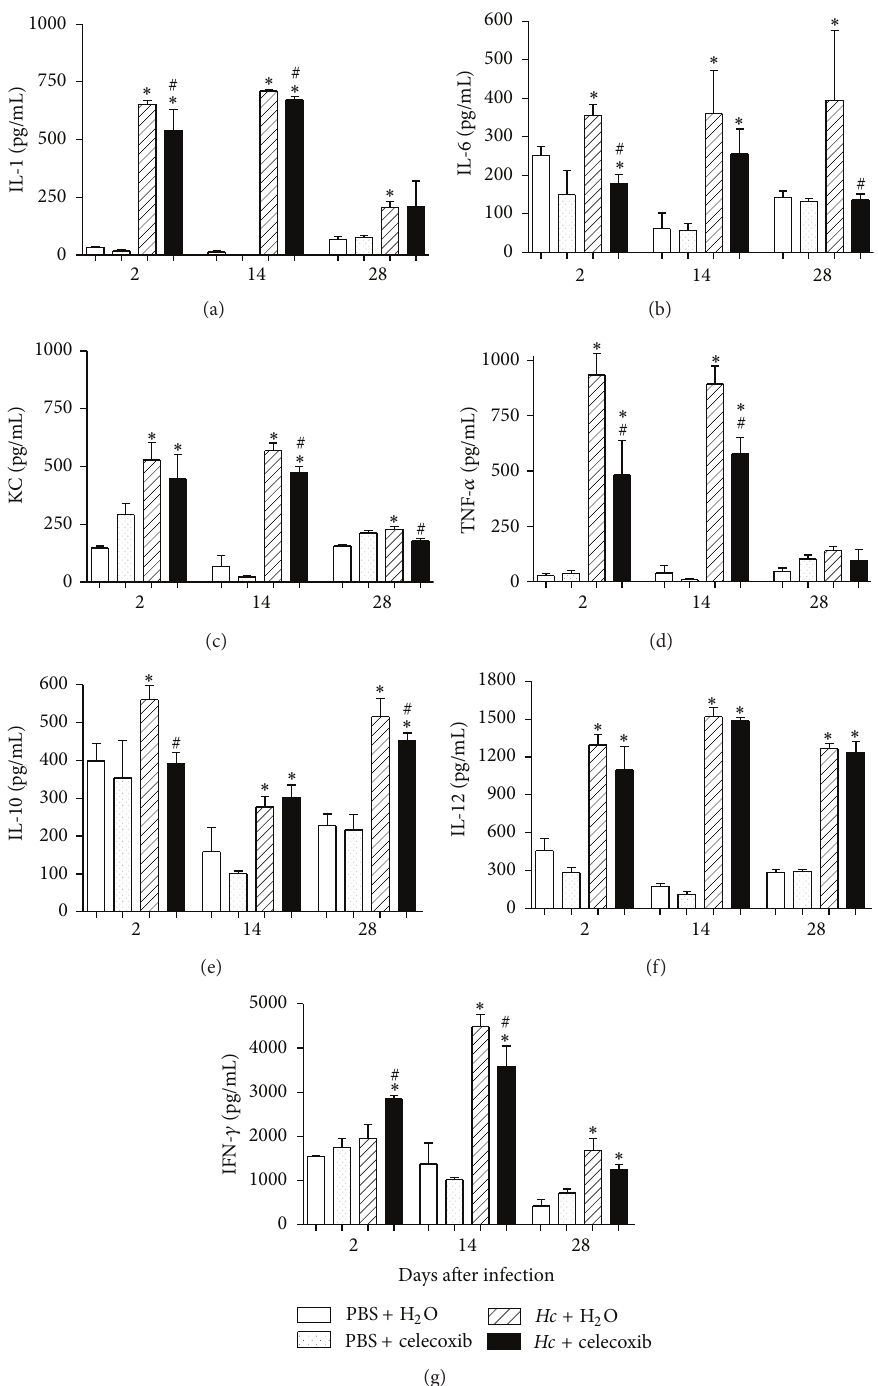
Figure 6: Treatment with celecoxib alters cytokine concentrations in the lung tissue of infected mice. The lungs were removed at 2, 14, and 28 days after i.t. inoculation and oral treatments and homogenized in medium. IL-1 (a), IL-6 (b), KC (c), TNF- 𝛼 (d), IL-10 (e), IL-12 (f), and IFN- 𝛾 (g) concentrations were determined using ELISA. The data are presented as the means ± SEM representative of three independent experiments (𝑛 = 5 - 6) . One-way ANOVA (Tukey’s multiple comparison test) was used. ∗ PBS + H 2 O versus Hc + H 2 O; # Hc + H 2 O versus Hc + celecoxib 𝑃 < 0.05